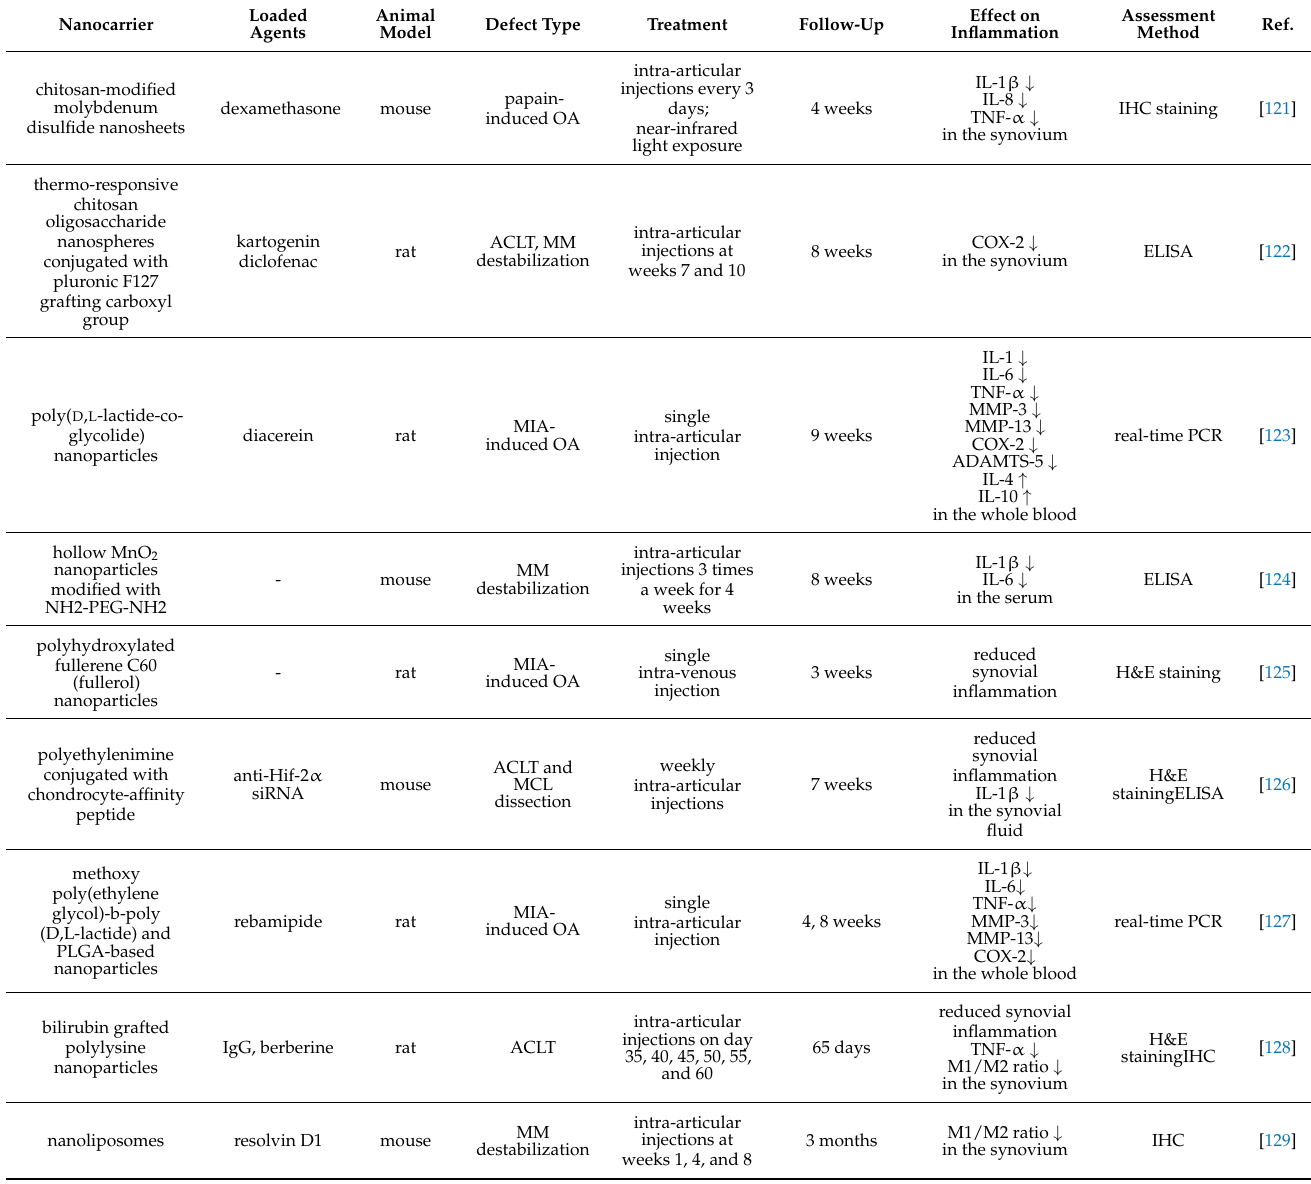
Table 3. Inflammation-targeting nanocarriers for treating cartilage defects in